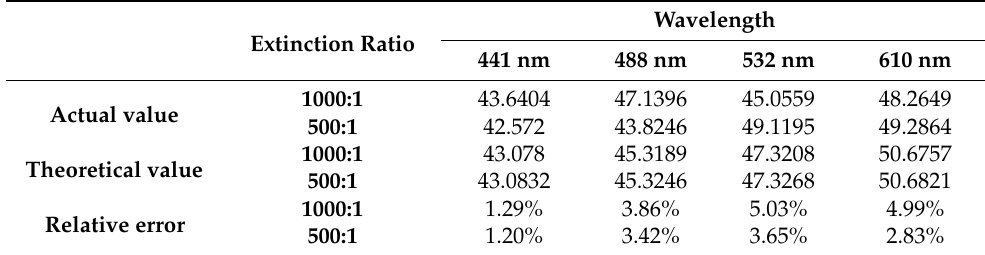
Table 2. The SNR and relative error of each wavelength (different extinction ratios of